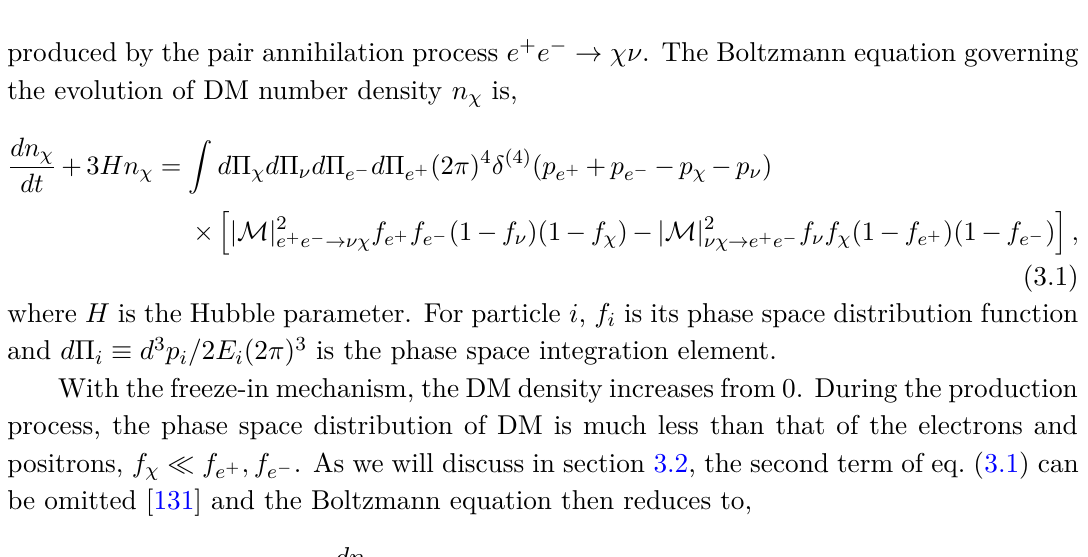
Figure 2 . The best fits (red star) and sensitivity contours of fermionic DM absorption at Xenon1T ( Left ) and PandaX-II ( Right ). Deeper color corresponds to smaller ∆ χ 2 and the white region has been excluded with ∆ χ 2 > 49 . For illustration, only the vector case is shown with best fit values m χ = 59 keV and Λ = 0 . 979 TeV at Xenon1T while m χ = 105 keV and Λ = 1 . 003 TeV at PandaX-II. The red dashed contour shows the 95% C.L. for comparison with other plots. In addition to data points (black), the inset plots demonstrate the background (red dashed) and total (blue solid) event rates with the corresponding best-fit